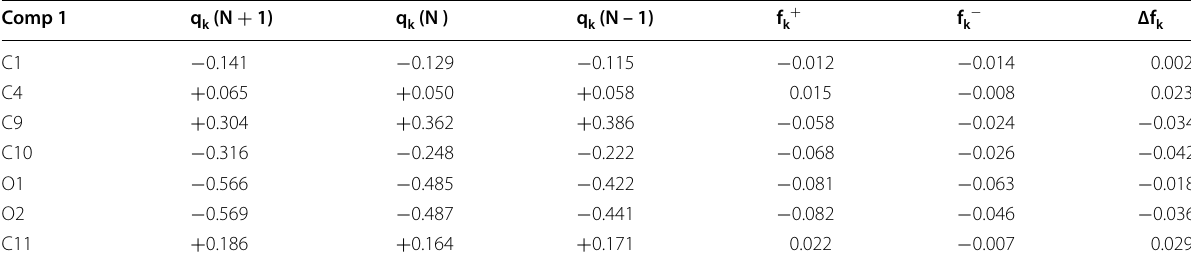
Table 2 Selected Mulliken atomic charges and Fukui functions for Compound 1